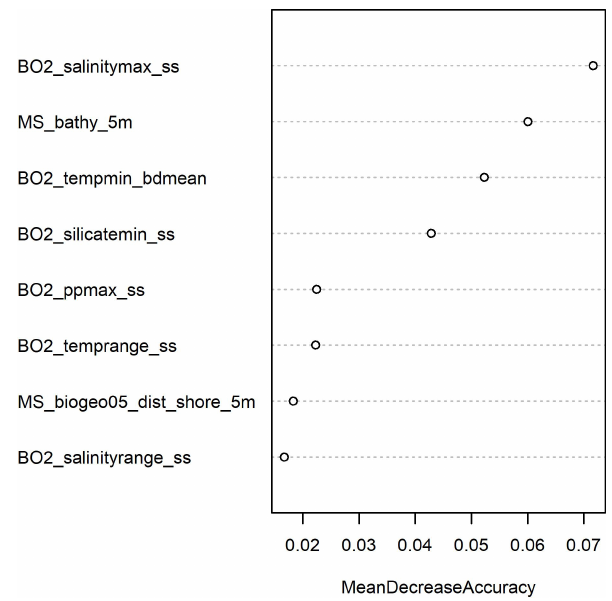
Figure 8. Random-forest variable